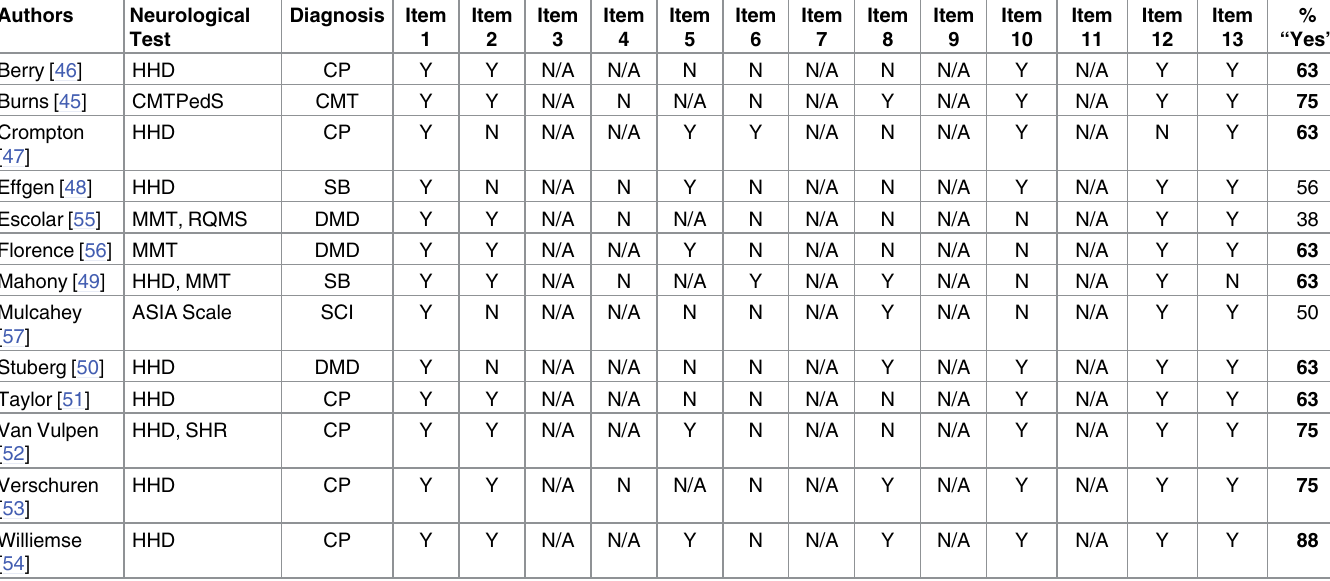
Table 3. Brink and Louw a critical appraisal summaryof the methodological quality of the clinimetric papers. ( n = 15). Authors Neurological